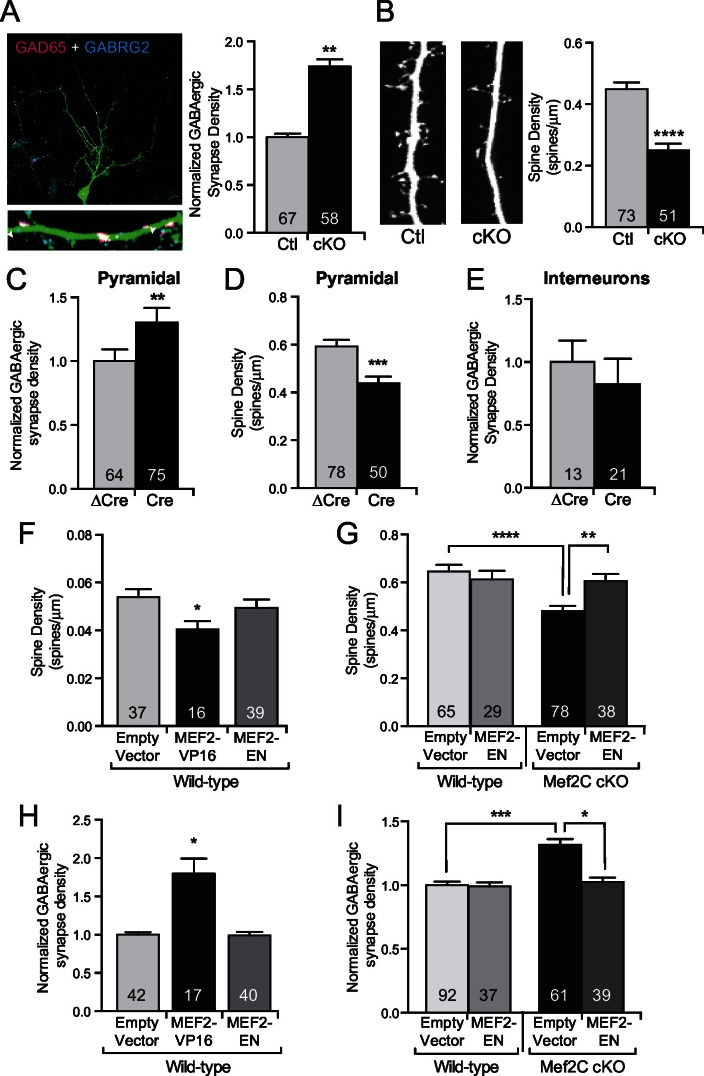
MEF2C functions as a transcriptional repressor to regulate synapse development in postsynaptic cortical pyramidal neurons.(A) Representative image of a GFP expressing mouse cortical neuron immunostained with antibodies against GAD65 (pre-synaptic) and GABRG2 (post-synaptic). Quantification of inhibitory synapse density (see Materials and methods) on Mef2c cKO neurons showed an increase compared to wildtype control neurons. (B) Representative image of spine density across a dendritic stretch. Quantification of spine density on Mef2c cKO neurons showed a reduction compared to wildtype control neurons. (C) Quantified GABAergic synapse density onto Mef2cfl/flcortical pyramidal neurons transfected at DIV4 with either Cre-GFP (Cre) or an enzyme-dead mutant of Cre-GFP (ΔCre). (D) Quantified spine density onto Mef2cfl/fl cortical pyramidal neurons transfected at DIV4 with either Cre-GFP (Cre) or an enzyme-dead mutant of Cre-GFP (ΔCre). (E) Quantified GABAergic synapse density onto Mef2cfl/flGAD65 positive interneurons transfected at DIV4 with either Cre-GFP (Cre) or an enzyme-dead mutant of Cre-GFP (ΔCre). (F) Quantified spine density onto WT cortical pyramidal neurons transfected at DIV4 with either an empty vector, a constitutive transcriptional promoting form of MEF2C (MEF2-VP16), or a constitutive transcription repressor form of MEF2C (MEF2-EN). (G) Quantified spine density onto wildtype or Mef2c cKO neurons transfected with either an empty vector or MEF2-EN. (H) Quantified GABAergic synapse density onto WT cortical pyramidal neurons transfected at DIV4 with an empty vector, a constitutive transcriptional promoting form of MEF2C (MEF2-VP16), or a constitutive transcription repressor form of MEF2C (MEF2-EN). (I) Quantified GABAergic synapse density onto wildtype or Mef2c cKO neurons transfected with an empty vector or MEF2-EN. Data are represented as mean ± SEM. Number (n) of neurons (A,C,E,H,I) or of dendritic stretches (B,D,F,G) are reported in each bar. Statistical significance was determined by unpaired t-test (A–E), One-way ANOVA (F,H) or Two-way ANOVA (G,I) using GraphPad Prism. *p<0.05, **p<0.01, ***p<0.001, ****p<0.0001. Also see Figure 3—figure supplement 1.